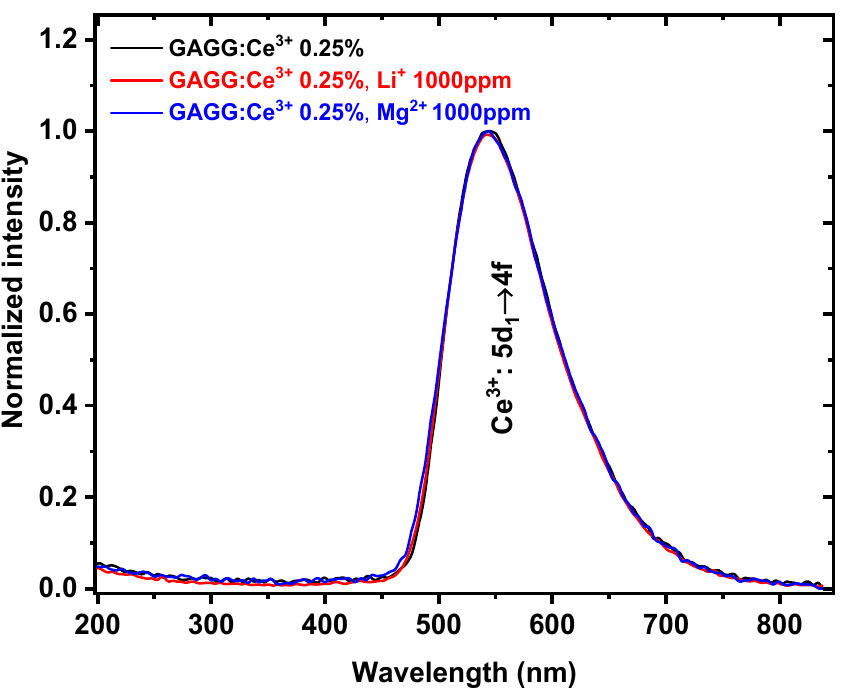
Figure 8. Radioluminescence spectra of Ce 3+ , Ce 3+ :Li + , and Ce 3+ :Mg 2+ doped GAGG single crystals, 300 K. The kinetics of scintillation decay offers important information on defect centers and their impact on scintillation parameters. The high dynamic ranges and timing of the decay experiments allow for precise convolution of the experimental curve and simultaneous replication of the rapid and slow components. The decay curves for Ce 3+ , Ce 3+ :Li + , and Ce 3+ :Mg 2+ doped GAGG single crystals are shown in Figure 9a. The decay curves are approximated by a double exponential function, which corresponds to radiative recombina- tion at the Ce 3+ and Ce 4+ centers. Table 2 summarizes the decay constants calculated from an experimental data fit. The scintillation decays and pulse-height spectra (see Figure 9b) show the distinct influence of Li + and Mg 2+ co-doping on the scintillation properties. The Li + co-doping markedly decelerates the scintillation response and increases the light yield values; see Table 2. The Li + -related defect can rather slowdown the e–h transport toward the Ce 3+ and Ce 4+ emission centers than provide quenching channels. This slowdown can be related to the appearance of the defect structure around 310 K; see Figure 7a. As a result, the charge carriers can temporarily be captured in this trap and, after some time, released back to the conduction band and delivered to the Ce 3+ /Ce 4+ luminescence centers (i.e., delayed radiative recombination). Furthermore, the small content of Ce 4+ luminescence centers could increase LY. On the contrary, Mg 2+ co-doping significantly accelerated the scintillation response and reduced LY. This can be due to the formation of Mg 2+ -based defect clusters [17]. Another reason is the decrease in the efficiency of Gd 3+ → Ce 3+ energy transfer [25]. This is caused by the decrease in the stable content of Ce 3+ ions due to the Ce 3+ → Ce 4+ conversion and the energy loss imposed by energy transfer from the Gd 3+ sublattice to the non-luminescent charge transfer absorption transition of Ce 4+